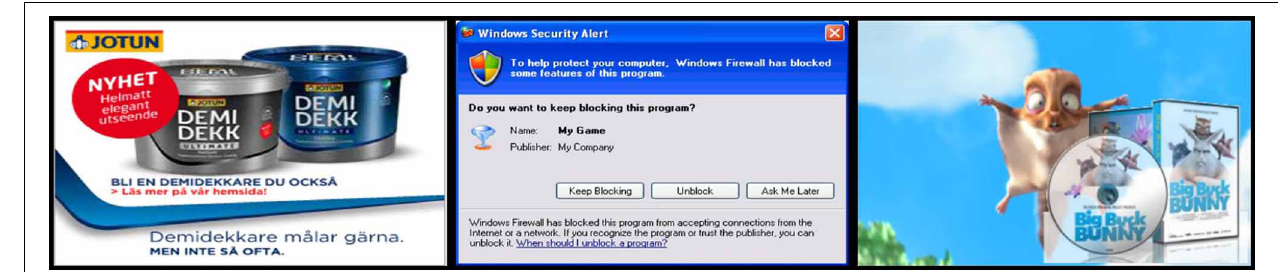
FIGURE 2 | In the task relevance conditions, the pictorial content of the adverts was manipulated to different degrees of task relevance. On the left hand side, an irrelevant advert in the control condition is shown. In the middle and on the right hand